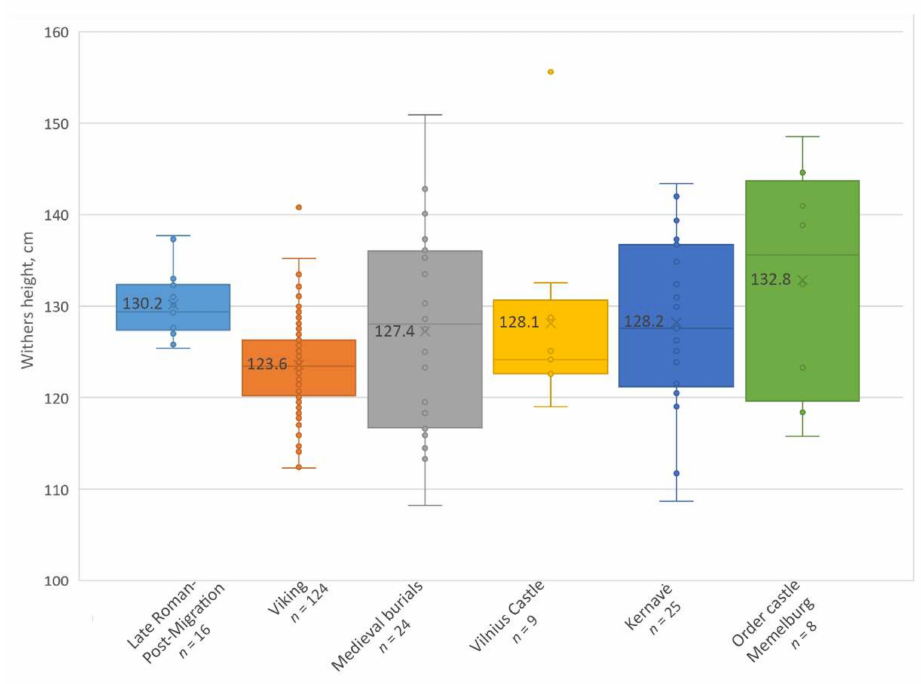
Figure 4. Boxplot showing withers height of horses during the Late Roman–medieval periods in Lithuania. Mean is written on the box and line demonstrates median.